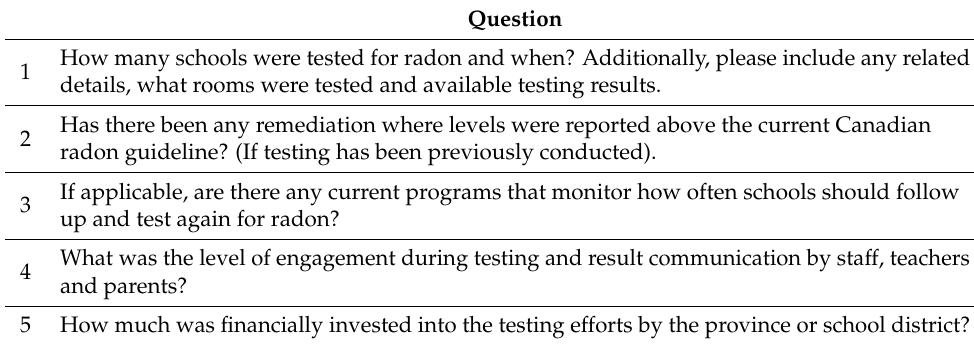
Table 1. Survey questions sent to gatekeepers.